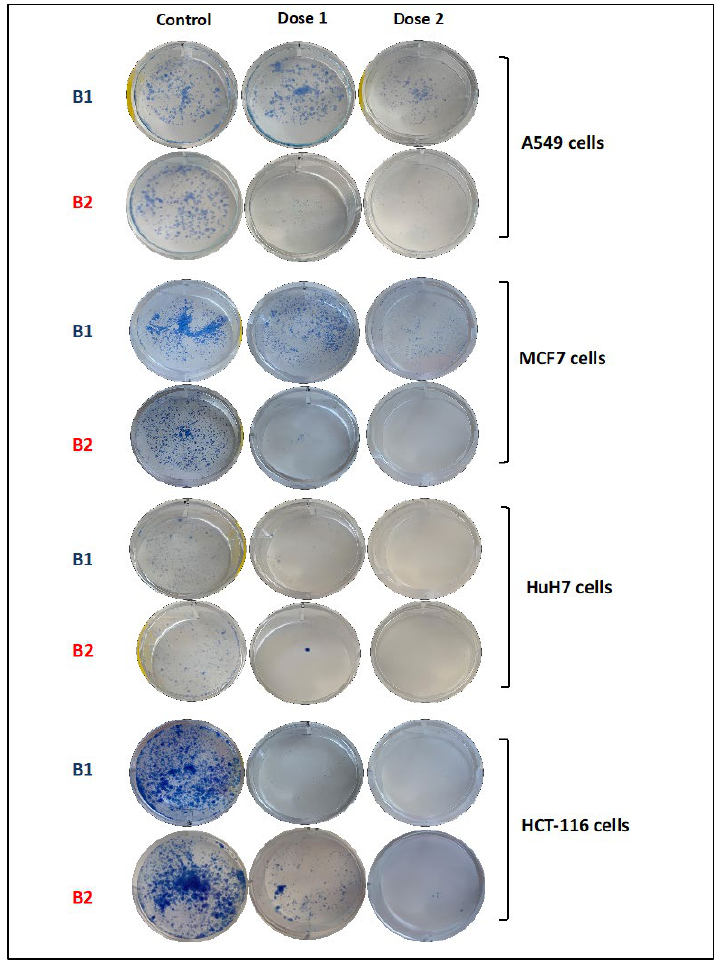
Figure 4. Colony formation assay, performed in the A549, MCF7, HUH7, and HCT116 cells exposed to B1 and B2 at two different concentrations (IC 50 and 2× IC 50 ) and equal amount of DMSO as control. Cells were allowed to grow for two weeks before staining with methylene blue solution.